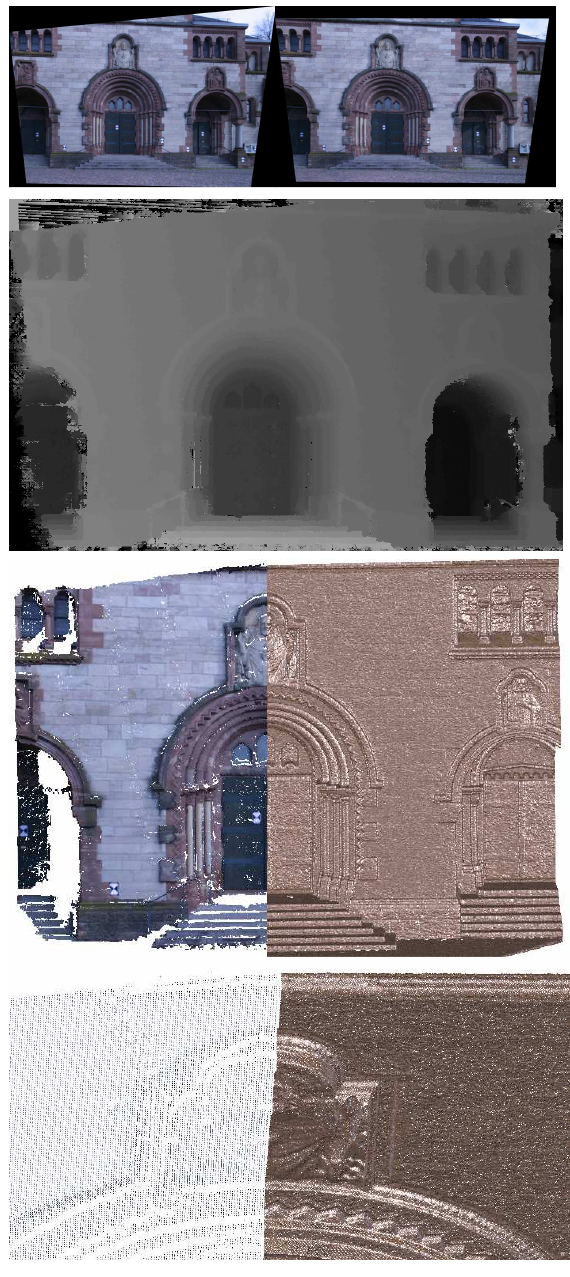
Figure 6. Results of SGM-SAP on the Herz-Jesus stereo-pair. Top : epipolar images of the stereo-pair; 2 nd row : estimated disparity map of the base image; 3 rd row : registration of the reconstructed point cloud onto the ground truth data; bottom : detail of the registration between the laser scanner point cloud and the image-based reconstructed